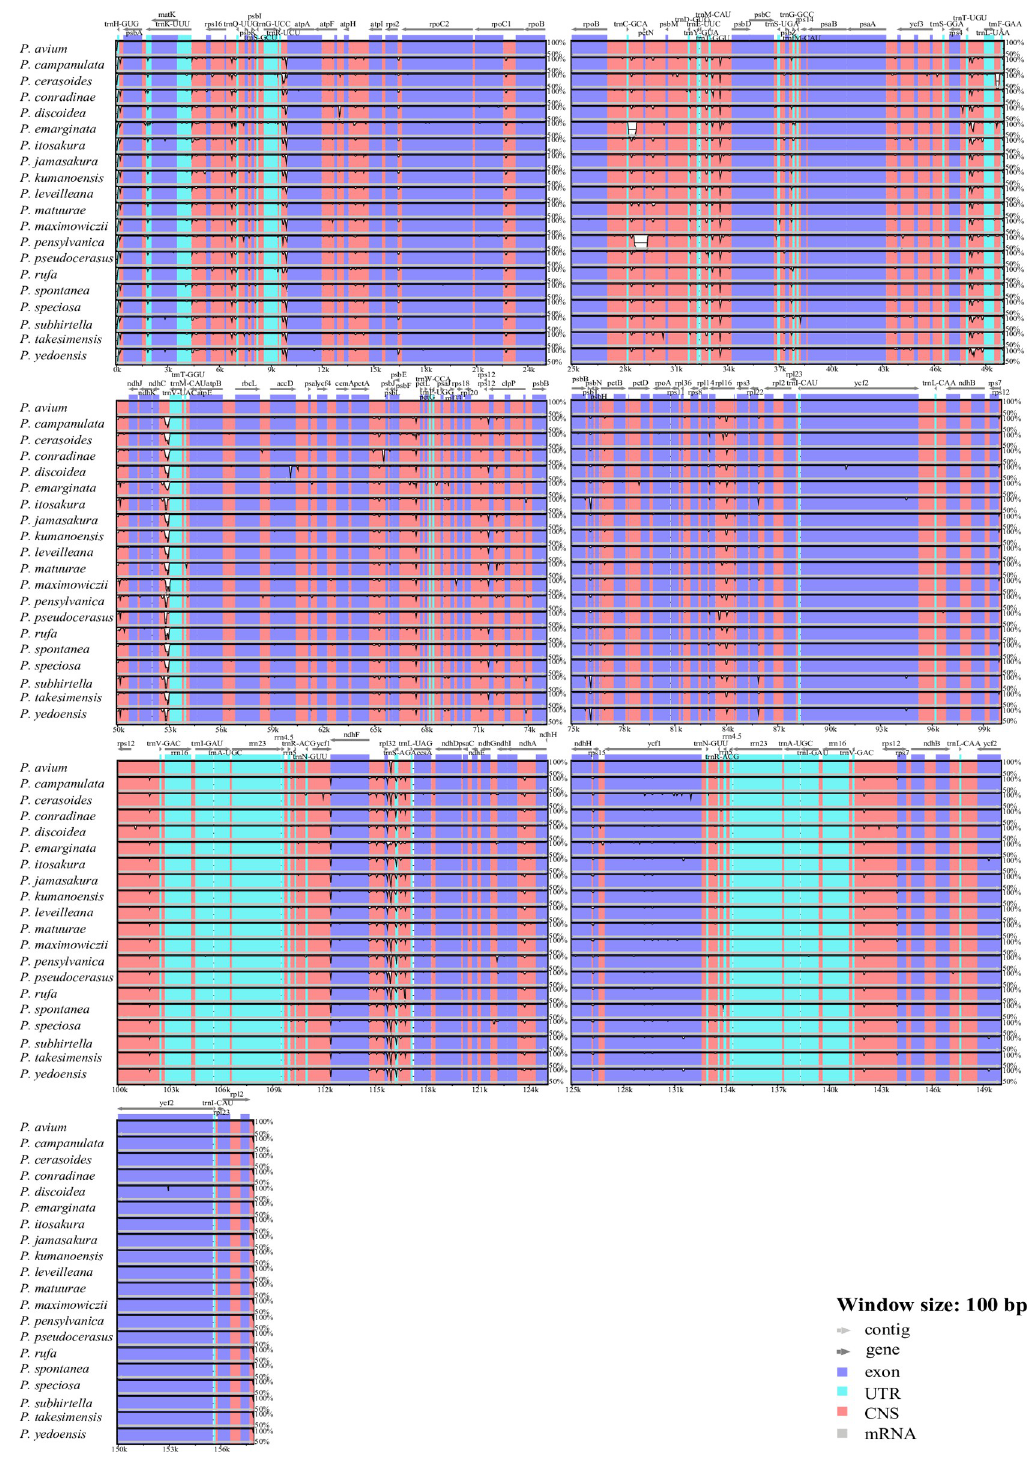
Fig 3. Sequence alignment of 20 subg. Cerasus plastomes with P . avium as the reference. The y-axis represents the percent similarity between 50% and 100%. Different colors represent different genetic regions.